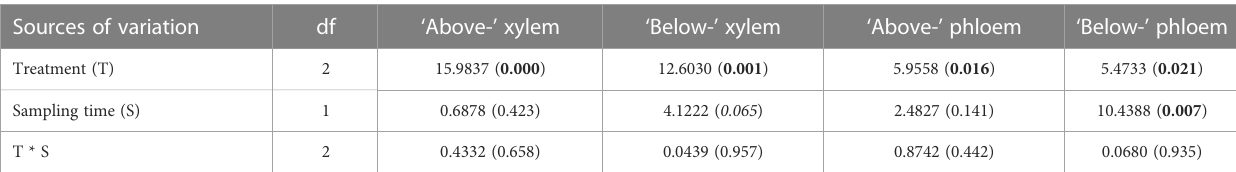
TABLE 2 Effects of treatment (control, xylem infusion, phloem infusion) and sampling date (3 weeks and 10 weeks after the infusion started), and their interaction on d 13 C values in xylem (sampled above and below the infusion point) and phloem (above and below the infusion point) of adult Pinus sylvestris trees, using the linear mixed-effects models.